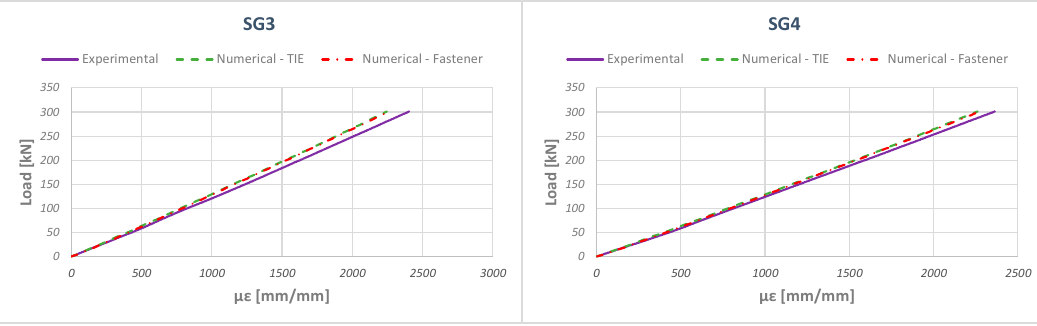
Figure 13. Numerical–experimental comparisons for SG-3 and SG-4: numerical TIE and Fasteners models.